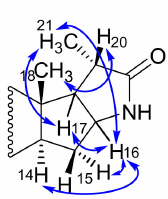
Figure 2. NOE and ROESY correlations diagram for compounds